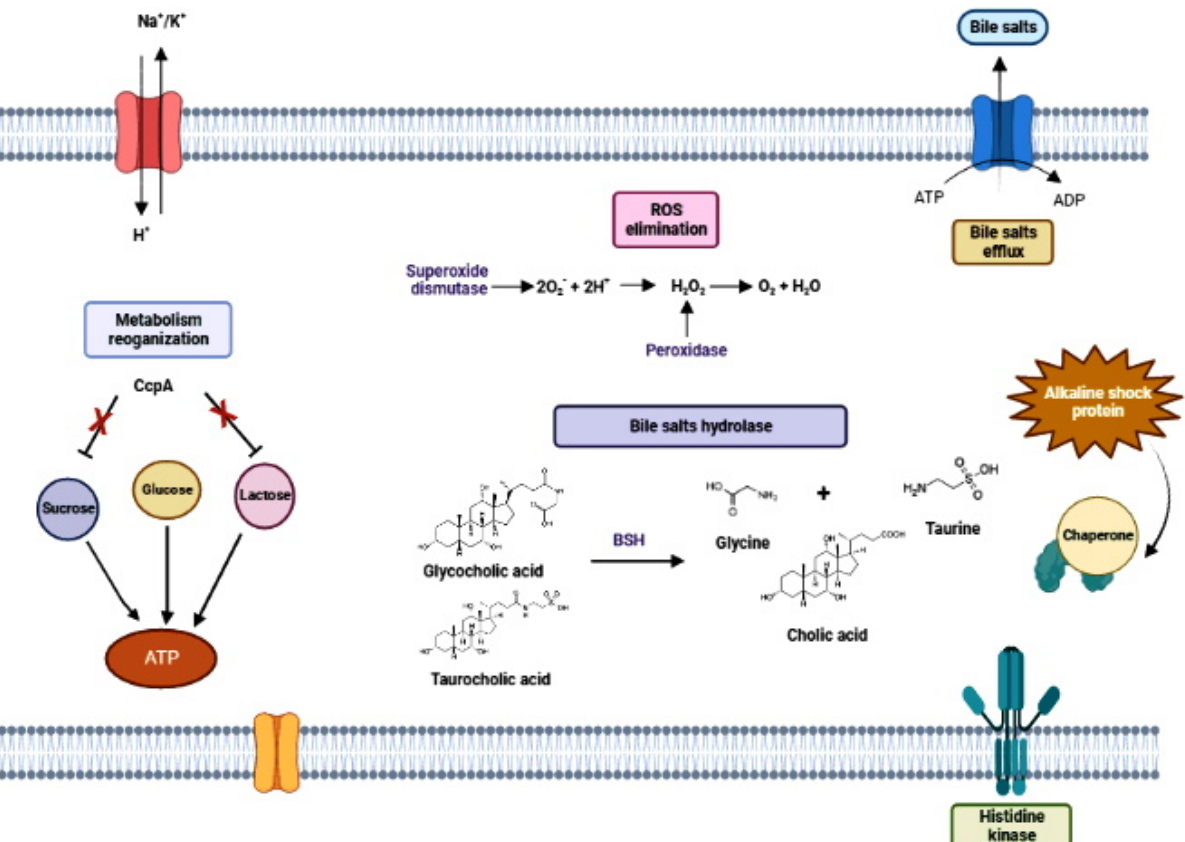
Figure 6. Overview of the main mechanisms of tolerance to intestinal tract stress conditions in lactic acid bacteria from the decomposition of reactive oxygen species (ROS), hydrolysis of bile salts and their excretion by extrusion pumps, antiport ion transport pumps and activation alkaline shock response proteins.